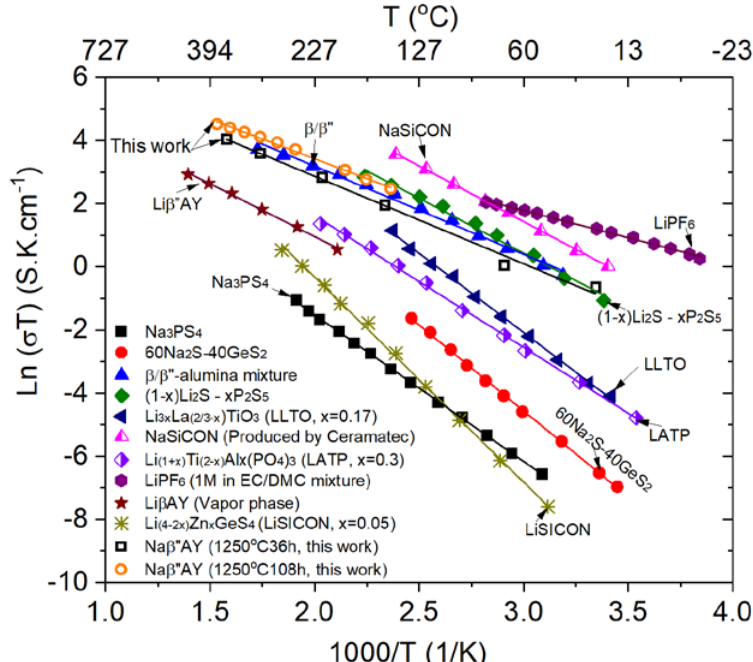
Figure 11. An Arrhenius plot of the measured conductivity of Na β AY and some common Na and Li electrolytes. Conductivity sources: Na 3 PS 4 [23], 60Na 2 S-40GeS 2 [23], β / β ”-alumina mixture [15], (1 − x)Li 2 S − xP 2 S 5 [23], Li 3x La (2/3 − x) TiO 3 (LLTO, x = 0.17) [27], NaSiCON (Produced by Ceramatec) [23], Li (1+x) Ti (2 − x) Al x (PO 4 ) 3 (LATP, x = 0.3 [29], LiPF 6 (1M in EC/DMC mixture) [26] , Liβ”AY (Vapor phase) [25], Li (4 − 2x) Zn x GeS 4 (LiSICON, x = 0.05) [28].